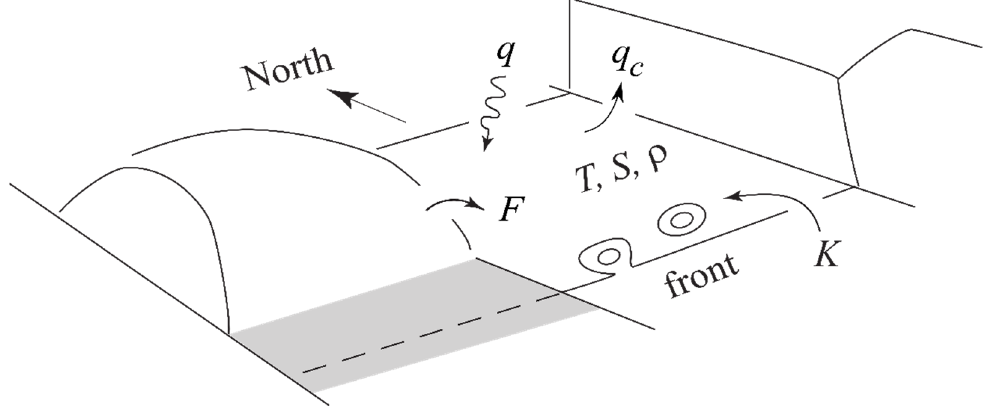
Figure 3. The configuration of the coupled ocean/atmosphere model is composed of warm and cold boxes aligned at mid-latitudes and a continental ice sheet injecting an anomalous freshwater flux into the subpolar ocean. Given the (known) global-mean fields, we examine cold-box deficits in temperature ( T ), salinity ( S ), and hence density surplus ( 𝜌 ), when forced by the cold-box deficit in the absorbed SW flux ( q ) and the anomalous freshwater flux ( F ). Internal variables include the MOC ( K ) and convective flux ( 𝑞 (cid:3030) ) that enter the ocean heat balance. To illustrate the basic working of our climate model, we draw in Figure 4 the phase- space diagram spanned by the MOC (abscissa) and density surplus (ordinate; markings pertain to temperature), so the climate state is the intersect of two lines: the density curve (thick solid) regulated by thermohaline balance of the ocean and the “MOC line” (sloping dashed) encoding the MOC dependence on density, as discussed next.